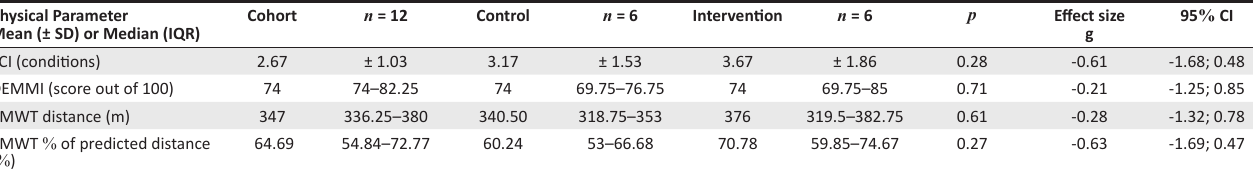
TABLE 3: Comparison of physical parameters as measured at hospital discharge ( n = 12). Physical Parameter Cohort n = 12 Control Mean (± SD) or Median (IQR)